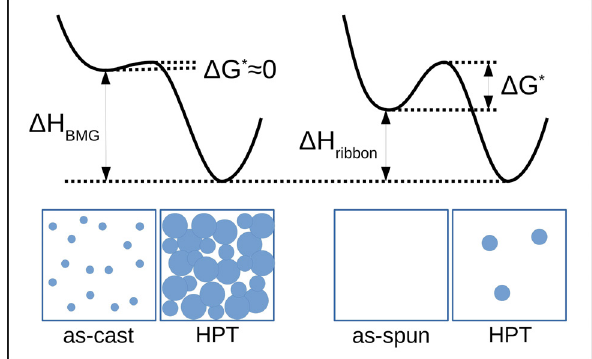
Figure 3: Schematic free energy curves of the as-cast Cu 60 Zr 20 Ti 20 BMG and the corresponding amorphous ribbon. ∆ H BMG and ∆ H ribbon denotes the enthalpy release during continuous calori- metric measurement. ∆ G* is the activation barrier for nucleation. Bottom images indicate that the as-cast BMG glass contains crys-